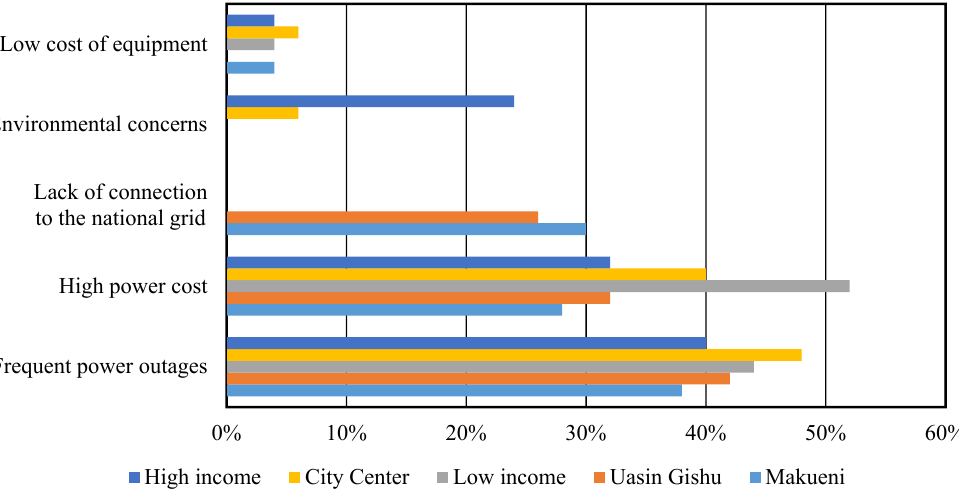
Figure 5. Motivation to invest in renewable energy sources.